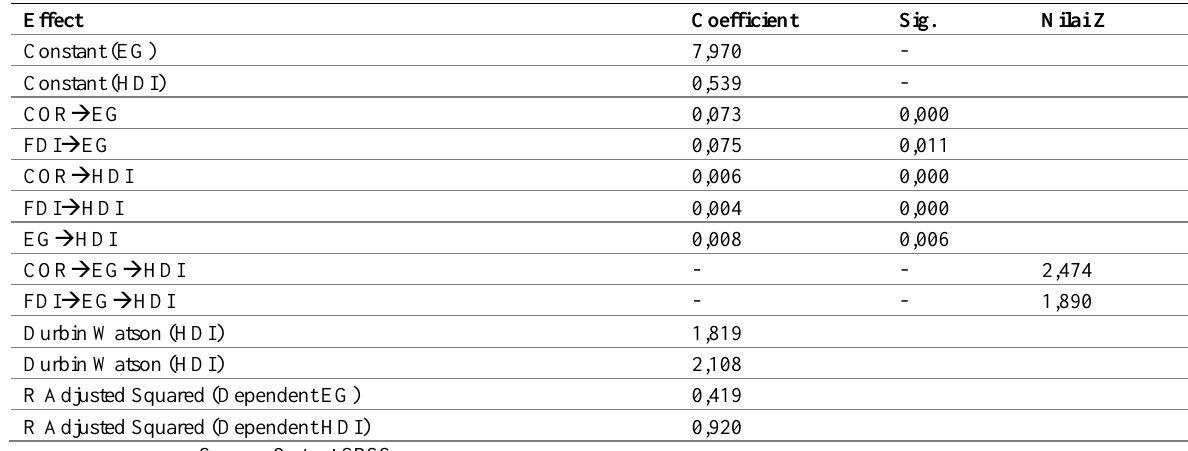
Table 6: The Result of Path